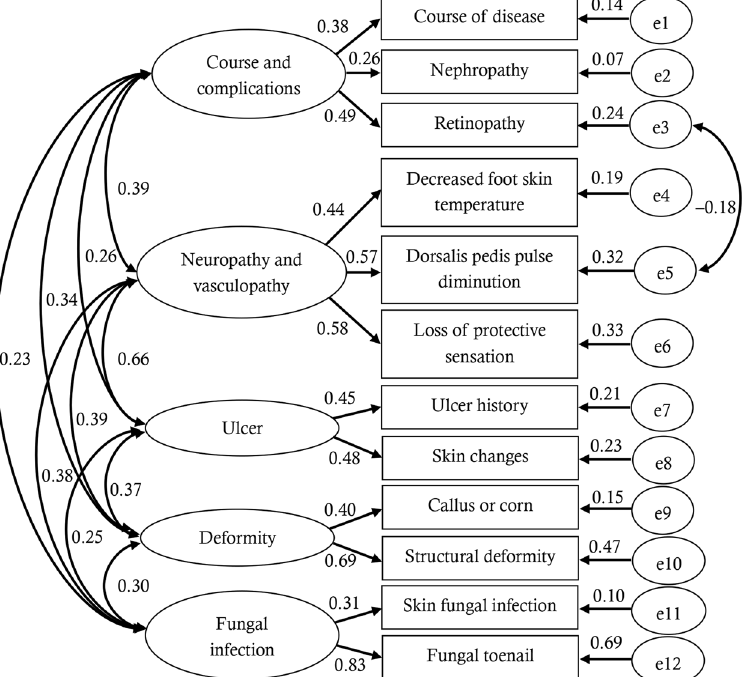
Figure 1. Confirmatory factor analysis model. Local dependency was identified between two items (retinopathy and dorsalis pedis pulse diminution). Except nephropathy and fungal infection of foot skin, most items had acceptable factor loadings on their dimensions.